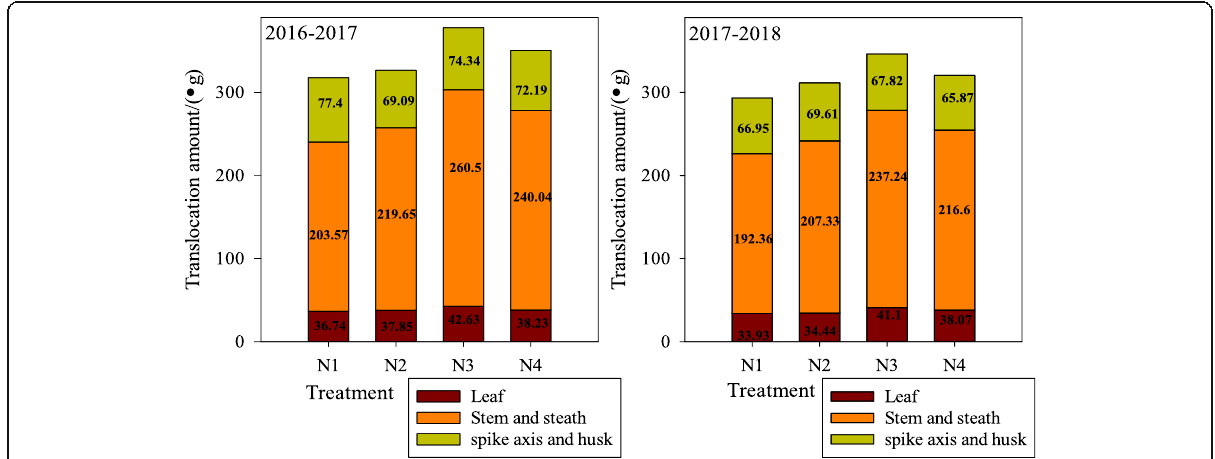
Fig. 5 Effects of four split nitrogen fertilizer treatments on 13 C photosynthate translocation amount in vegetative organ after anthesis